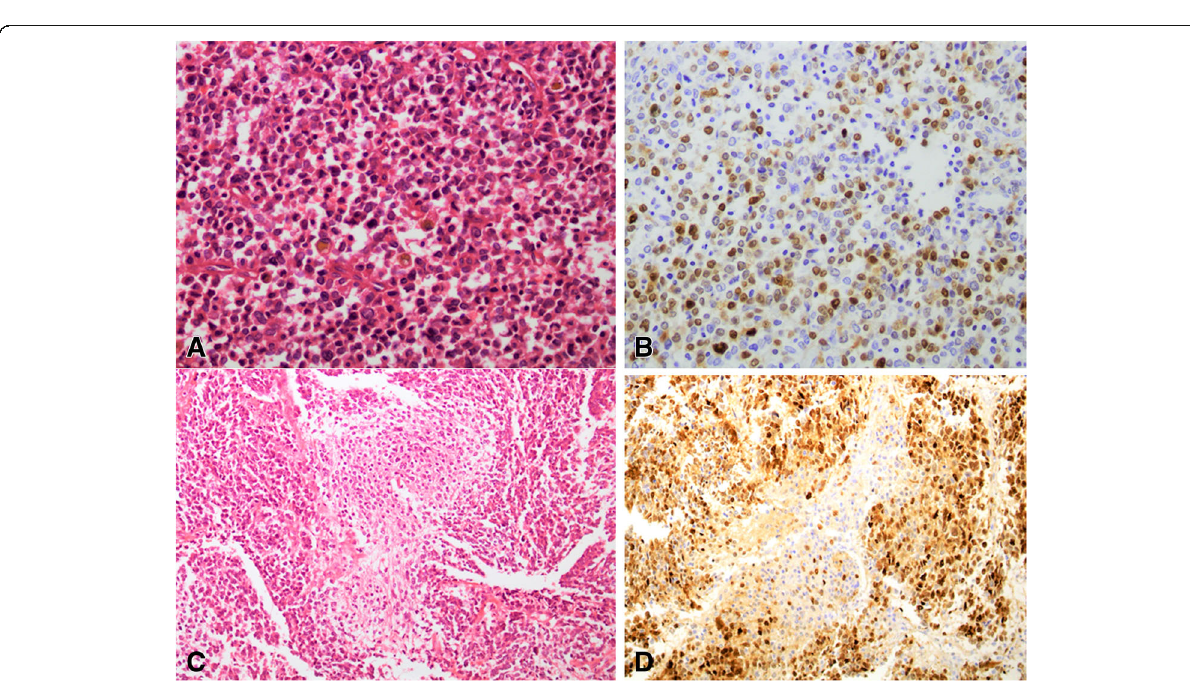
Fig. 3 Renal Ewing sarcoma exhibiting ( a ) mild to moderate staining of Cyclin D1 ( b ). Neuroblastoma with central neuropil ( c ), showing diffuse strong Cyclin D1 positivity ( d